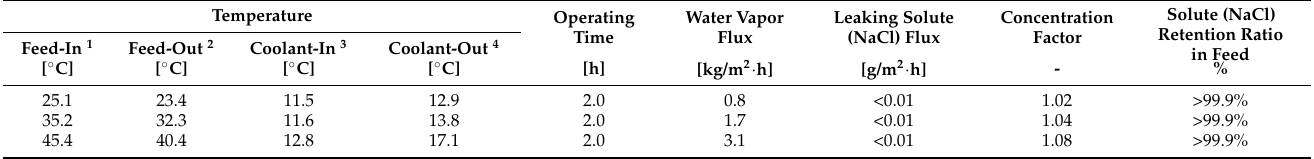
Table 2. Results of DCMD operation with 1000 ppm NaCl aqueous solution as feed at various